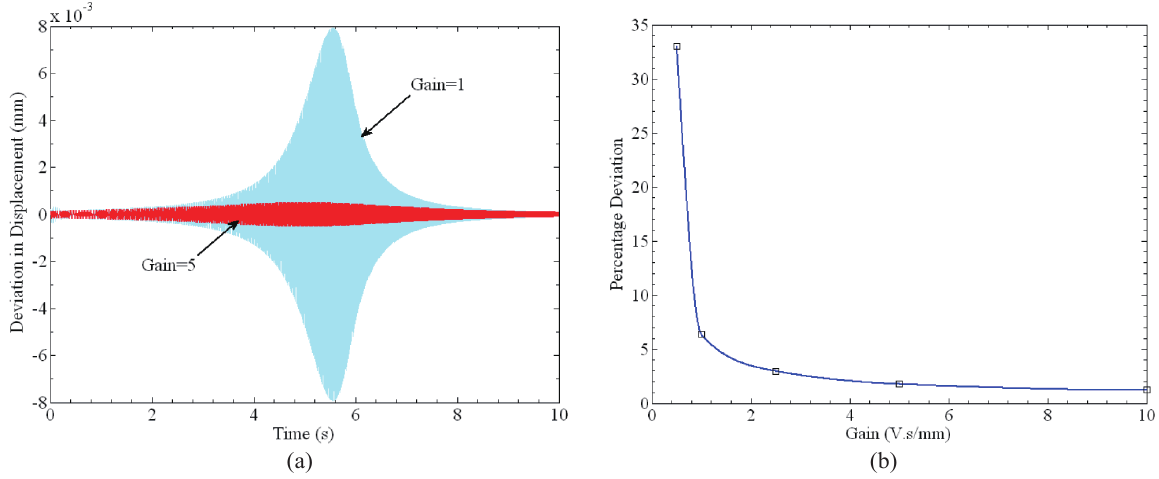
Fig. 11. (a) Deviation of results computed from non-linear and linear analyses and (b) maximum deviation as a percentage of maximumamplitude.